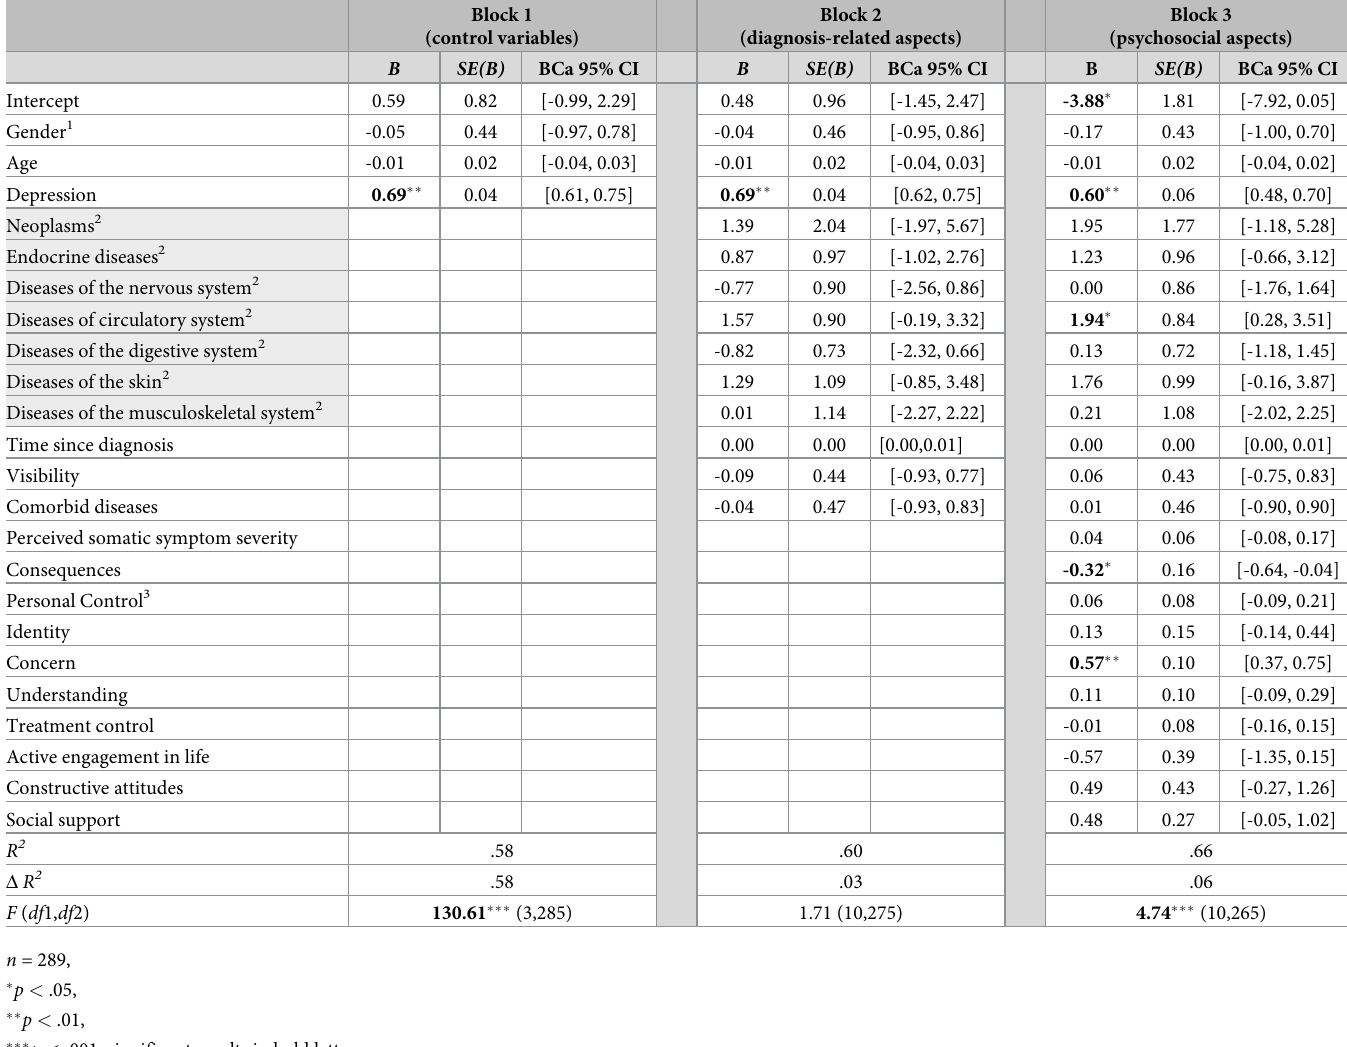
Table 3. Hierarchical linear regression model ( n = 289) with anxiety as dependent variable with 95% bias corrected and accelerated confidence intervals based on 1000 bootstrap samples. Block 1 (control